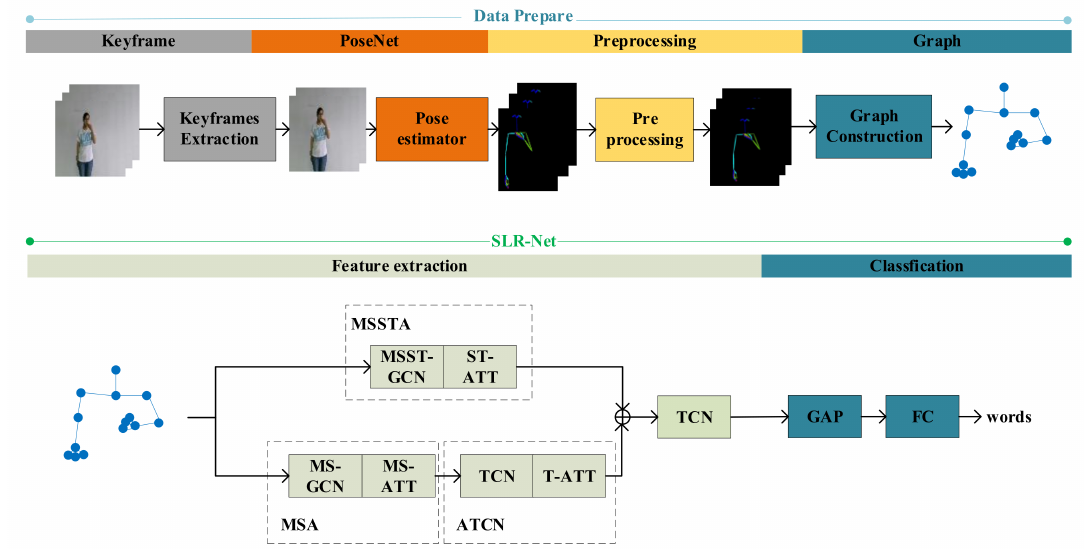
Figure 2. The overview of our proposed method. “ ⊕ ” means add operation.